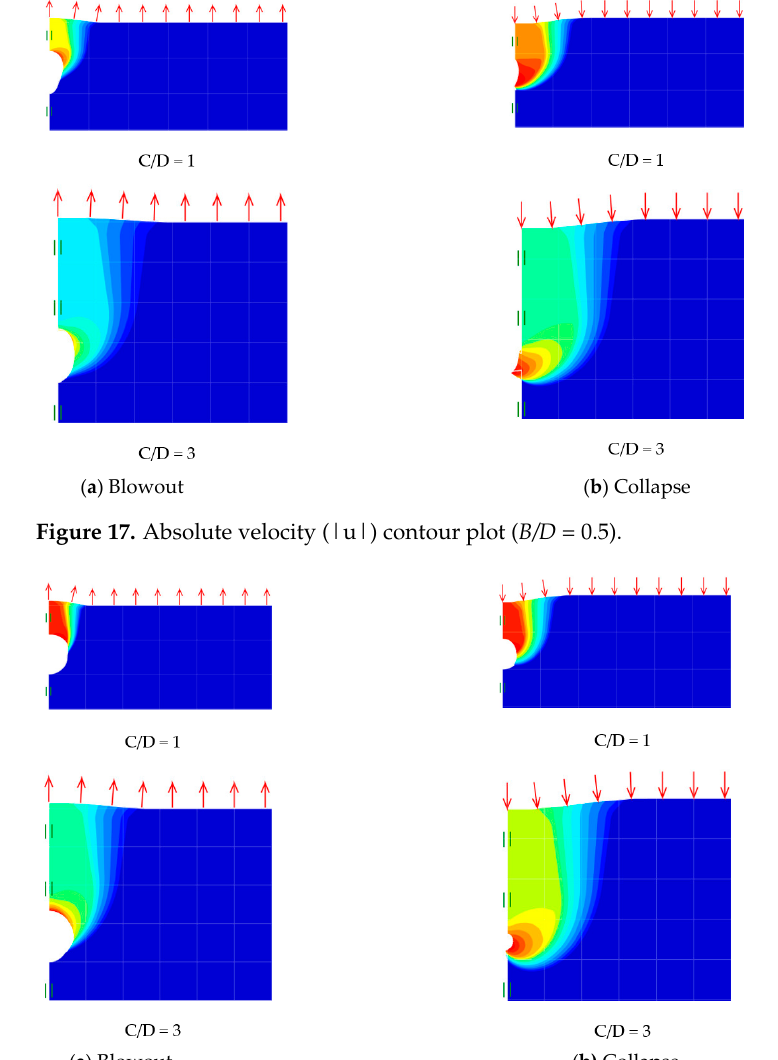
Figure 17. Absolute velocity (|u|) contour plot ( B/D = 0.5).